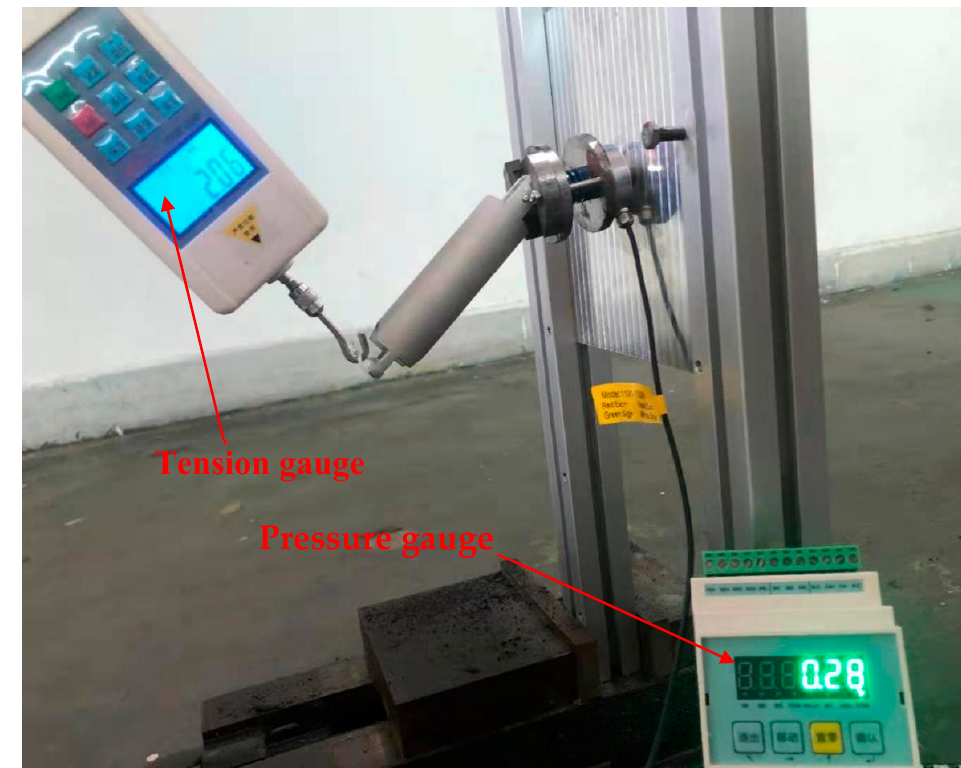
Figure 7. Experimental test platform.